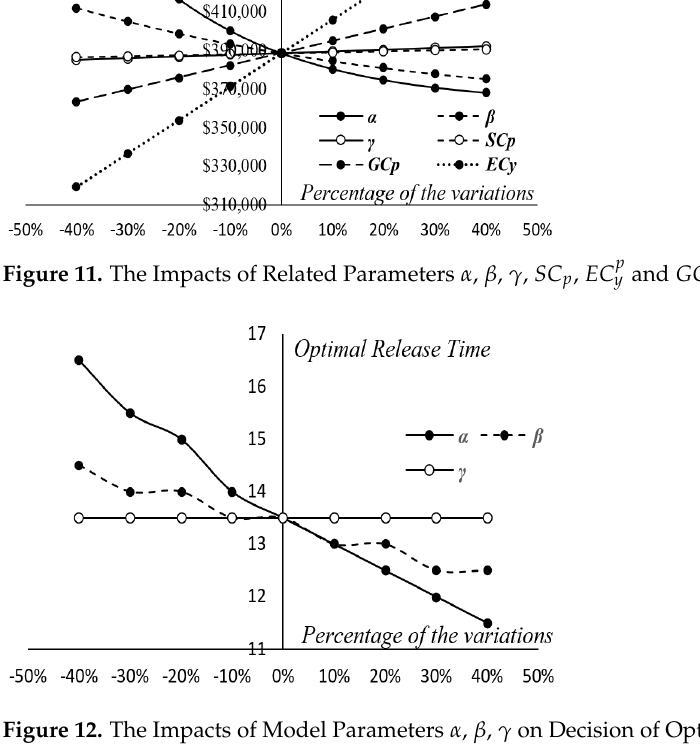
Figure 12. The Impacts of Model Parameters 𝛼 , 𝛽 , 𝛾 on Decision of Optimal Release Time.